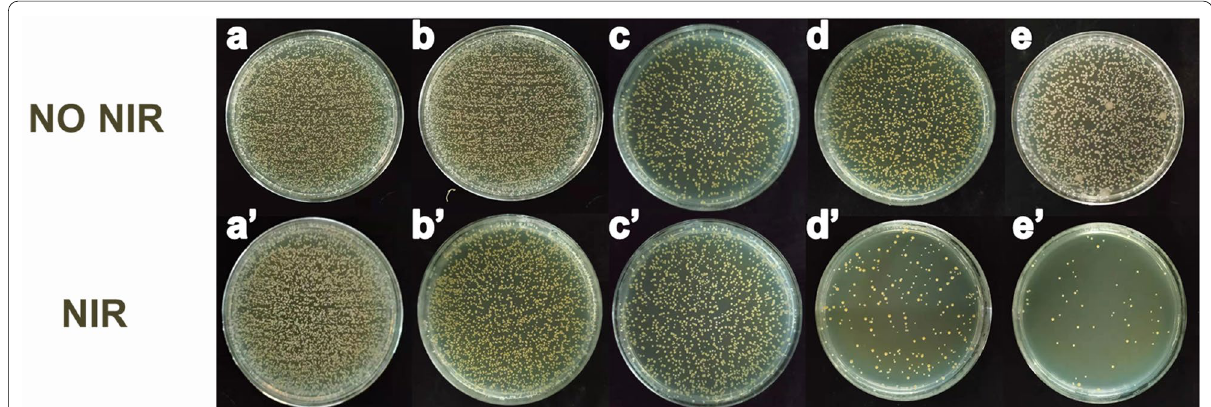
Fig. 5 Antibacterial performance of nanofiber doped with different samples against MRSA a – e without and a ′ – e ′ with 808‑nm light exposure: a , a ′ control group, b , b ′ UCNPs group, c , c ′ curcumin group, d , d ′ UCNPs@Curcumin with low‑dose group, and e , e ′ high‑dose